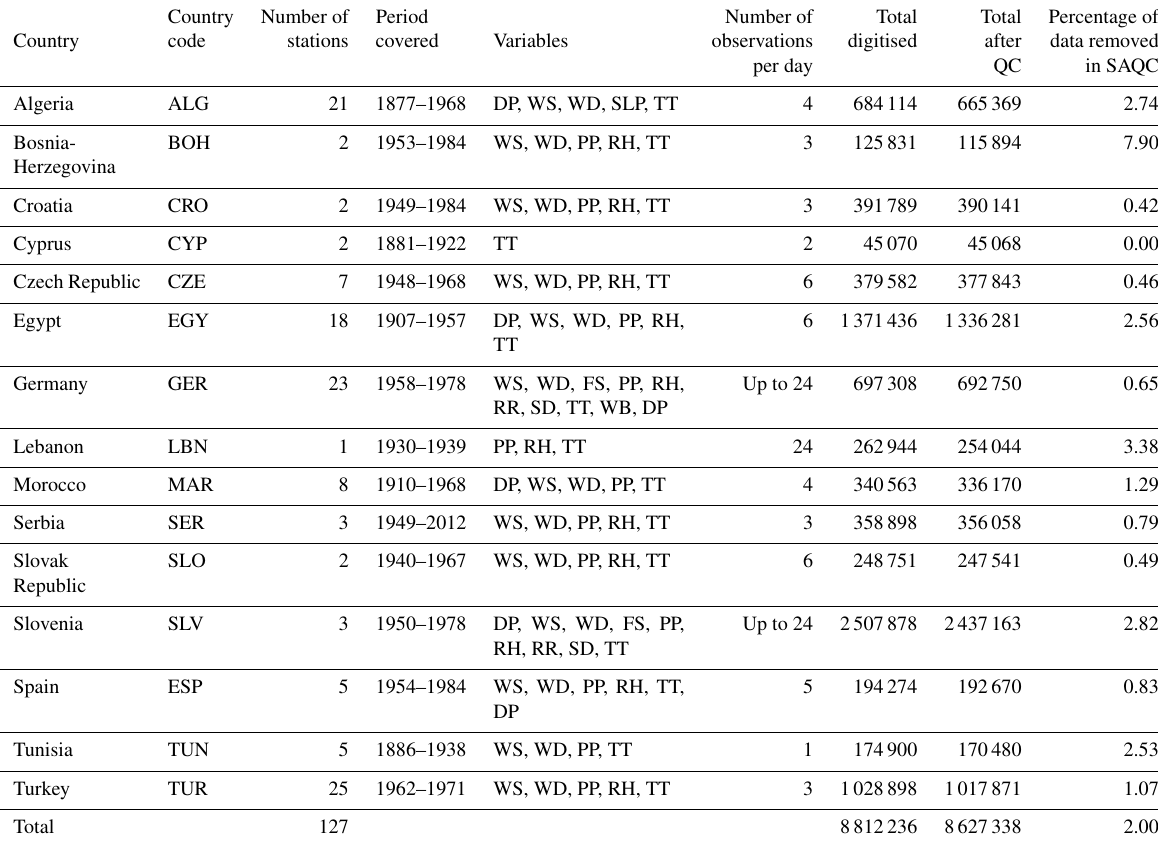
Table 6. Summary of stations digitised as part of this project. The variables are temperature (TT), relative humidity (RH), dew point temperature (DP), wind speed (WS), wind direction (WD), air pressure (PP, including sea level pressure and station level pressure), wet bulb temperature (WB), total snow depth (SD), fresh snow (FS) and precipitation (RR). The digitised dataset is available through the World Data Center PANGAEA (https://doi.pangaea.de/10.1594/PANGAEA.886511), in the format of one file for each variable and country. Country Number of Period Number of Total Total Percentage of Country code stations covered Variables observations digitised after data removed per day QC in